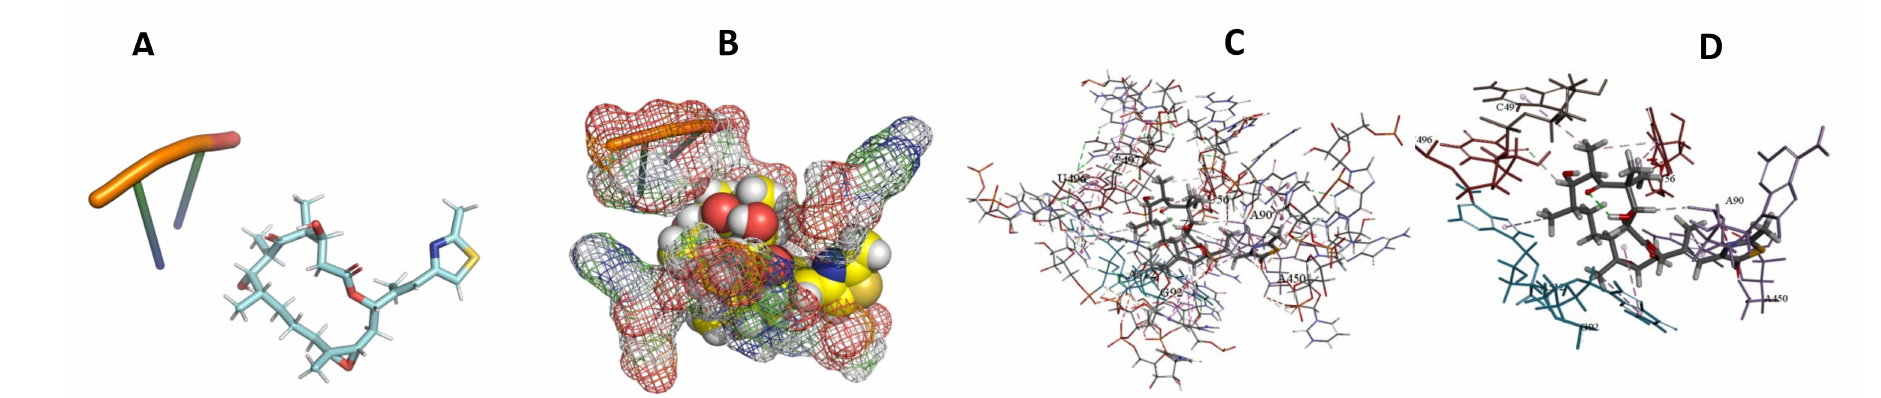
Figure 20. T. cruzi + Epothilone. ( A ): Best binding pose and nucleotides involved. ( B ): Schematic binding pocket. ( C ): shows the Nucleotides component that re involved in binding. ( D ): Shows the main bonds involved between the compound and the nucleotide component.